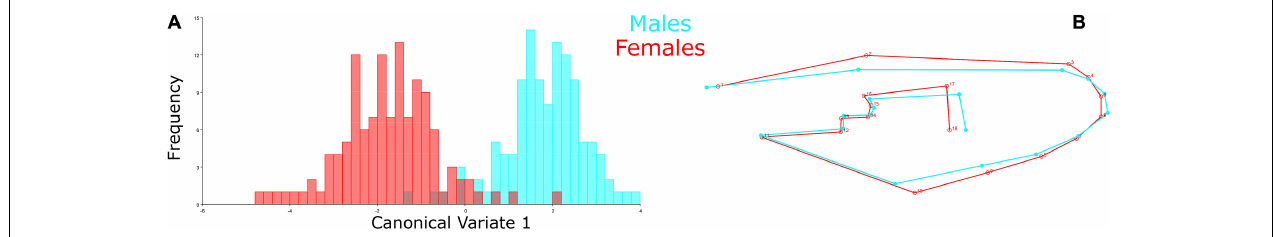
FIGURE 3 | Comparison between male and female specimens. (A) CVA represented in the morphospace to compare the wing shape variation patterns between males (blue) and females (red). X -axis: First canonical variate; Y -axis: Frequency of each wing shape. (B) Wireframe graph from the PCA displaying the mean value of wing shape variation in the male (blue) and female (red) populations.